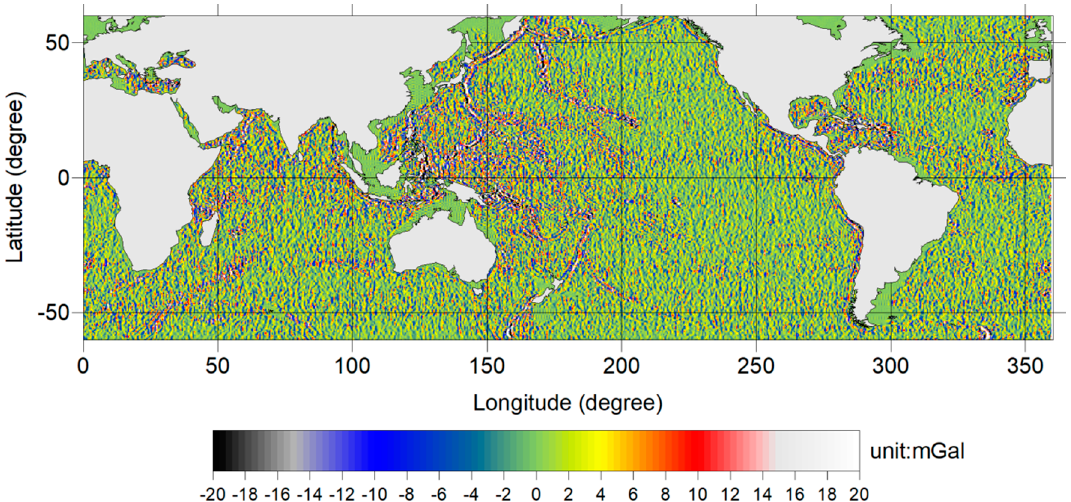
g δ Figure 8. The di ff erences between δ g from HY-2A (the combined version) and that from Figure 8. The differences between from HY-2A (the combined version) and that from EGM2008.